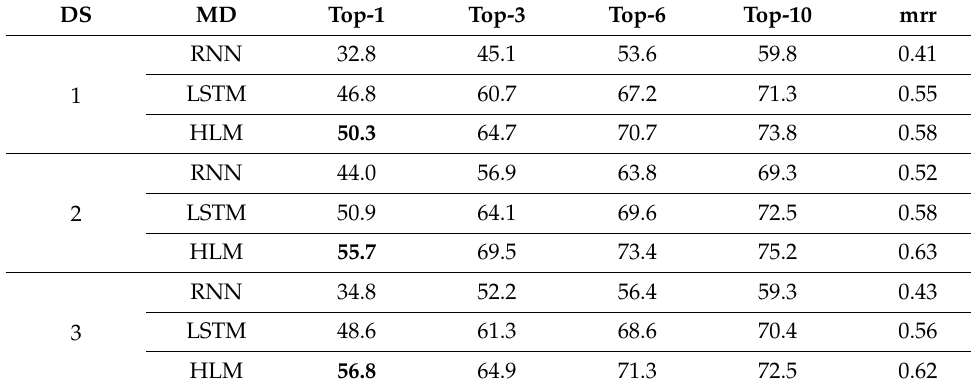
Table 2. Evaluation results on test